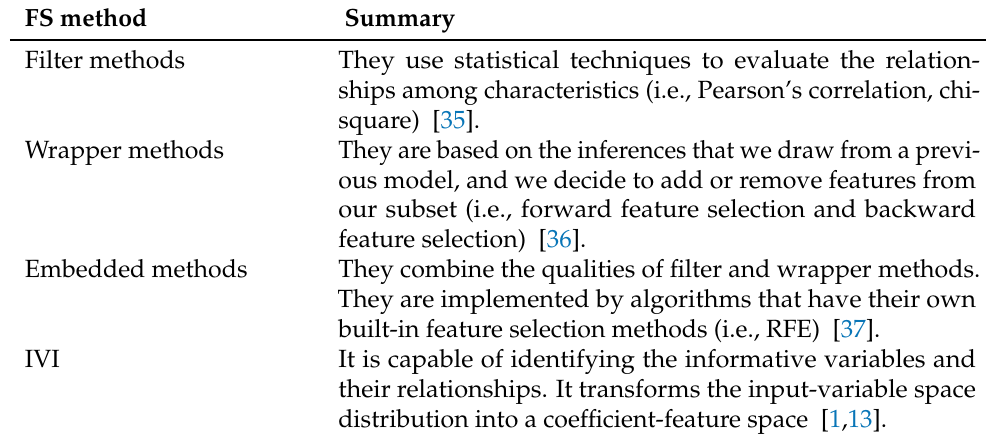
Table 1. Summary table of feature selection methods (FS) present in the literature according to the basic techniques used